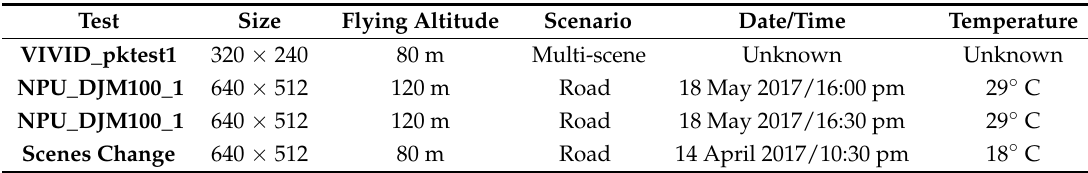
Table 3. Basic information of four test image